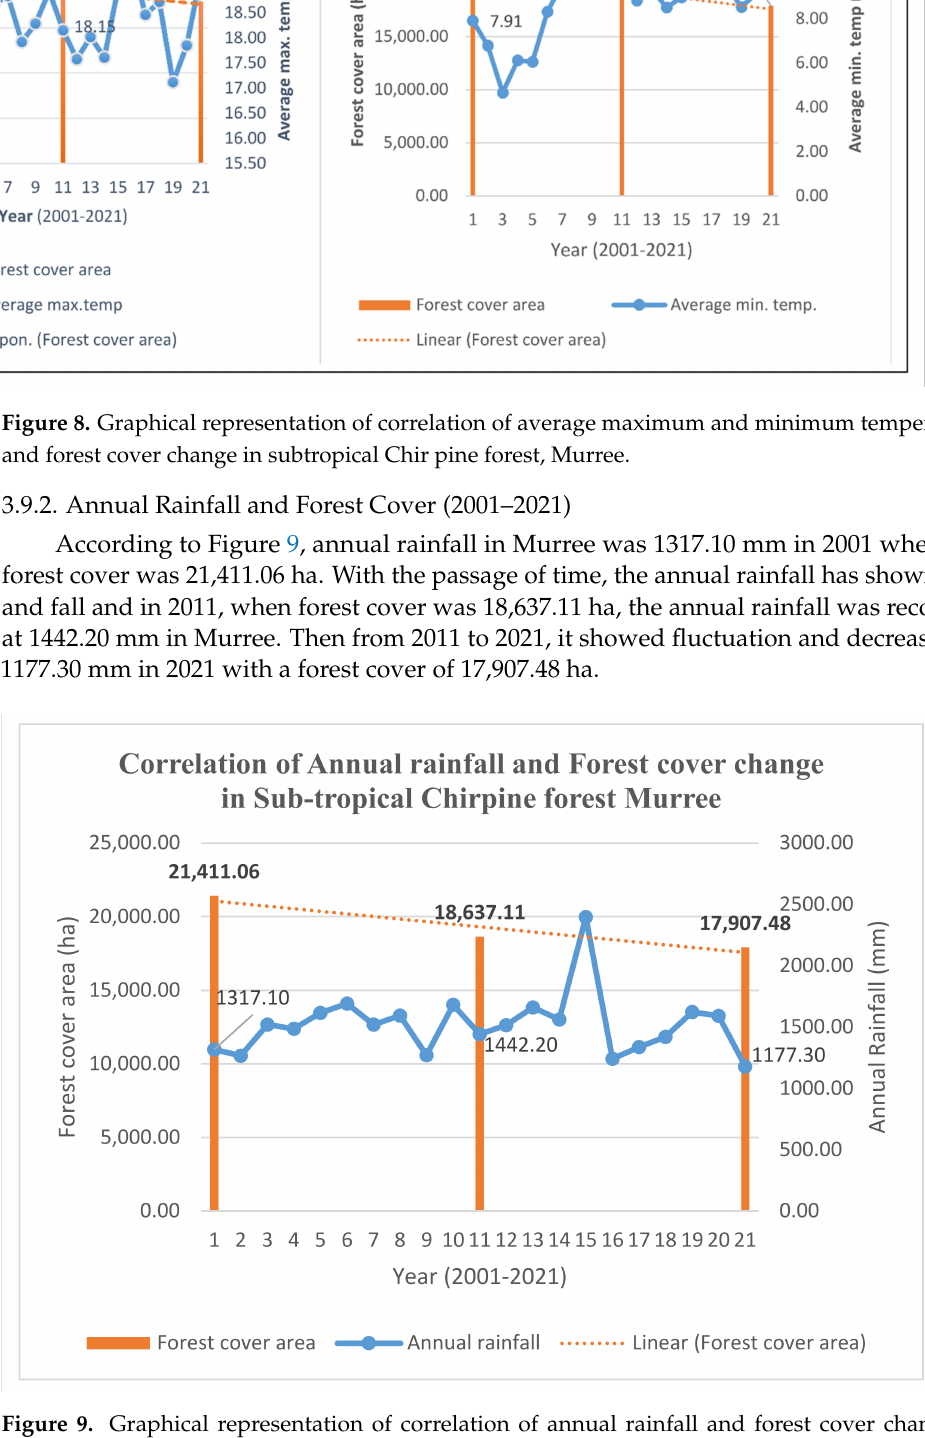
Figure 9. Graphical representation of correlation of annual rainfall and forest cover change in subtropical Chir pine forest,